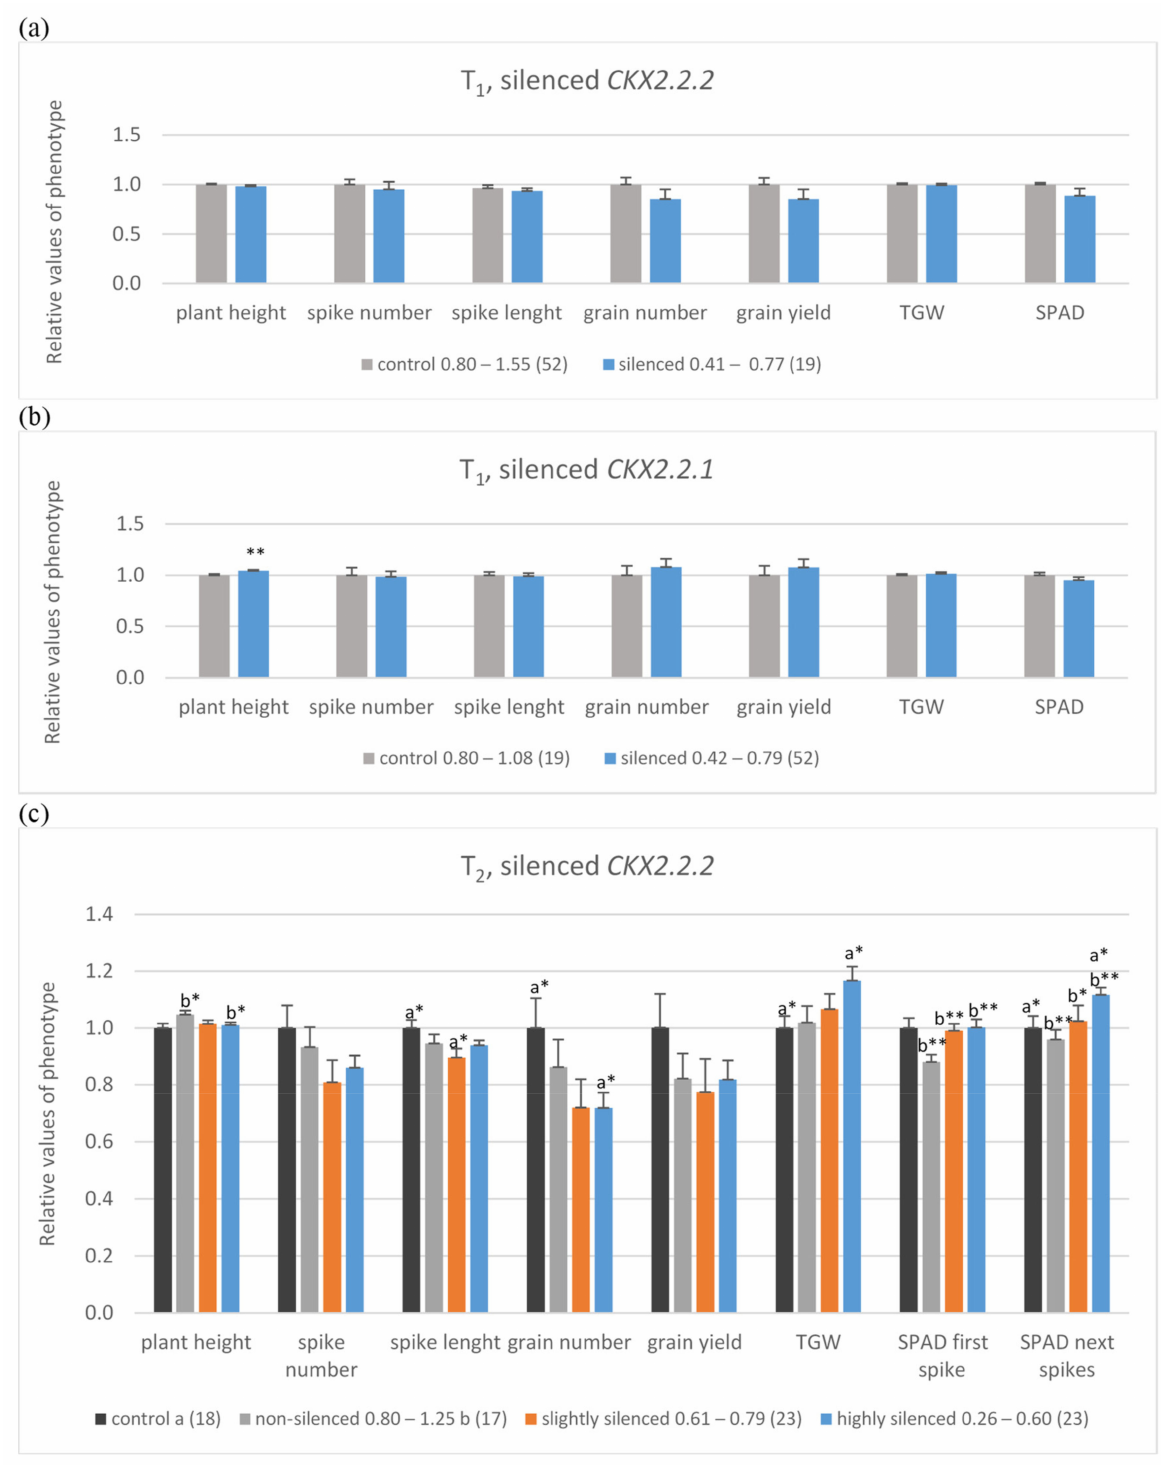
Figure 2. Mean, relative values of yield-related traits in control, non-silenced (grey bars), silenced (orange bars) or highly silenced (blue bars) plants of T 1 with silenced TaCKX2.2.2 ( a ) and TaCKX2.2.1 genes ( b ) and T 2 lines with silenced TaCKX2.2.2 , including R 2 , control (black bars) ( c ). SPAD was measured on the flag leaves of the first (SPAD first spike) or four next spikes (SPAD next spikes). The error bars denote ± SE. Different letters mean significant differences: *—significant at p ≤ 0.05; **—significant at p ≤